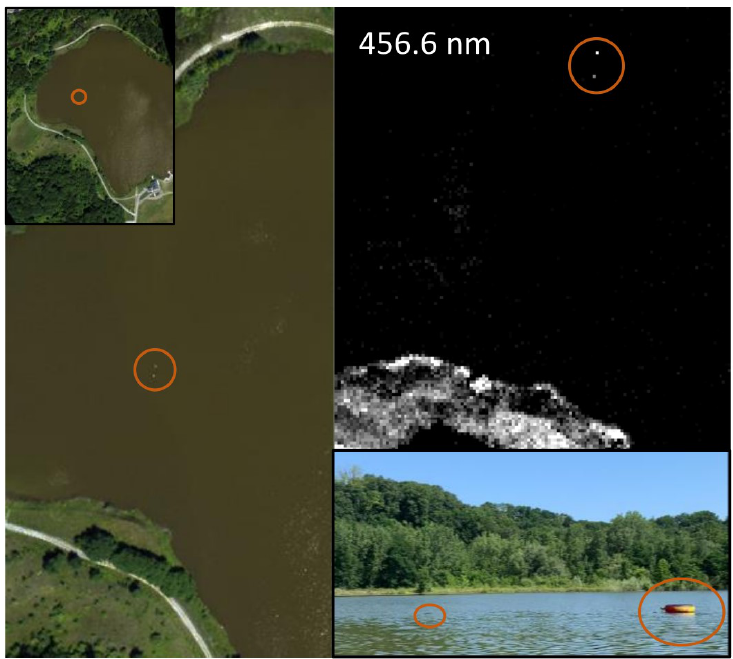
Figure 3. Floating SPARC targets (orange circles) deployed for MELM calibration of the airborne sensor at low signal levels appropriate to water-leaving radiance ( Lw)